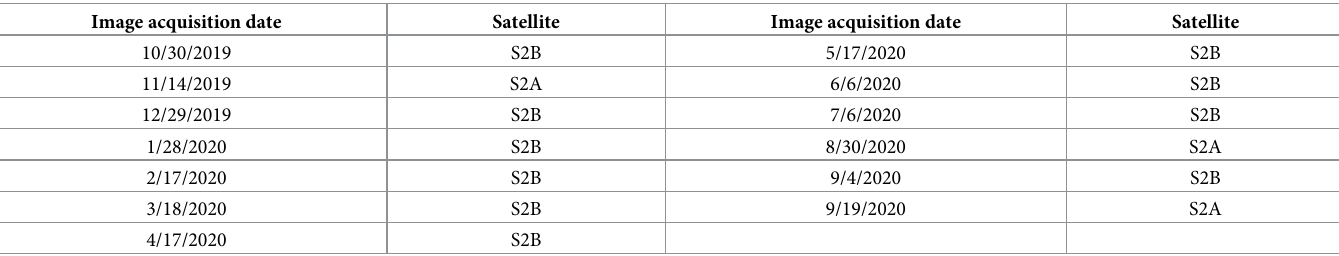
Table 2. Sentinel-2 image acquisition